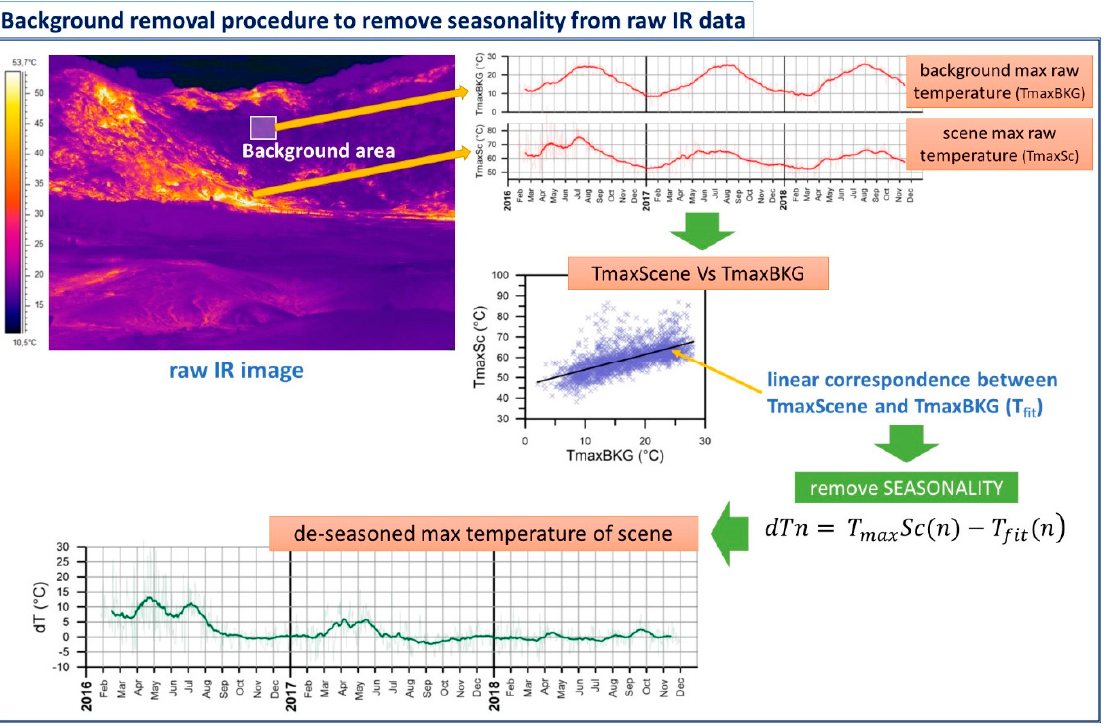
Figure 3. Processing scheme of background removal procedure (BKGr).